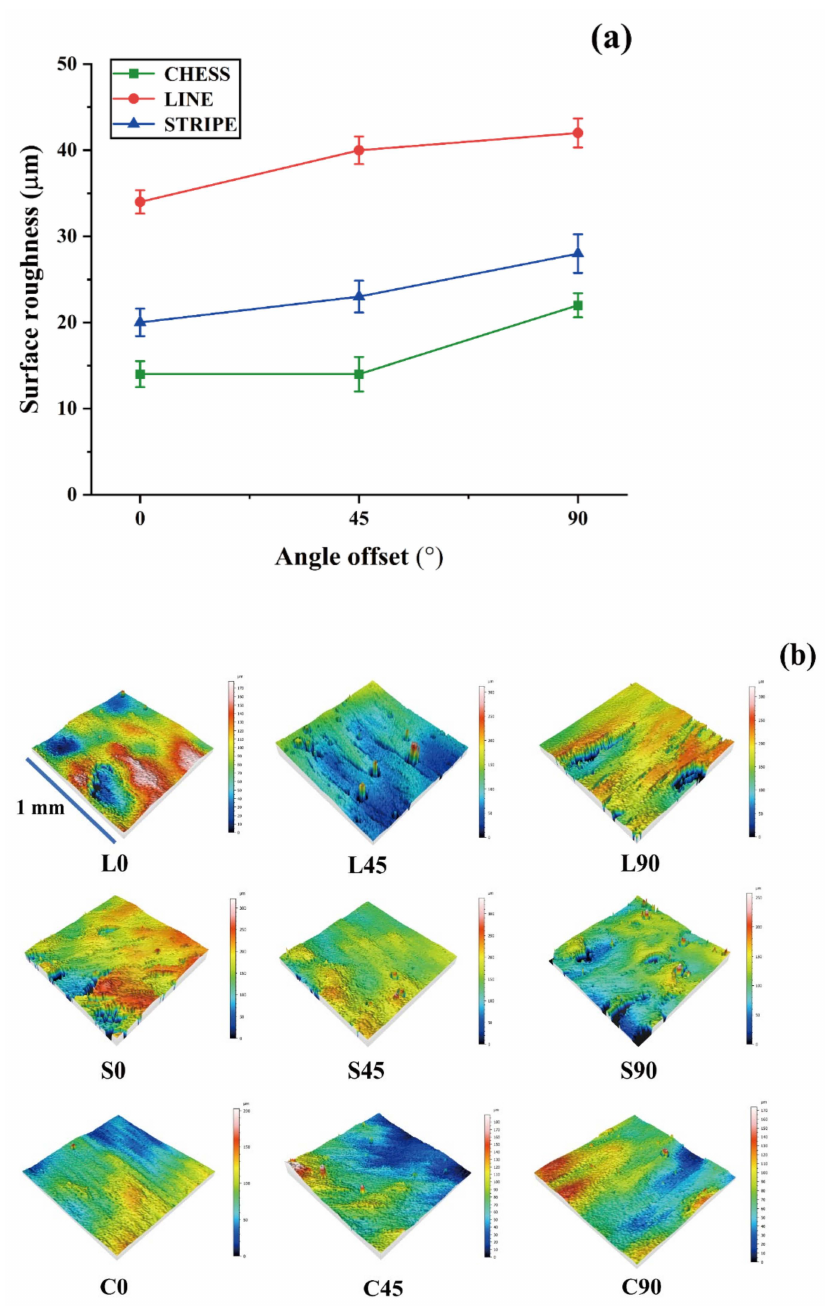
Figure 6. Surface roughness of L-PBF samples under different combinations of scanning strate- gies. ( a ) Surface roughness of L-PBF samples under different combinations of scanning strategies; ( b ) surface micro-morphologies of samples under different combinations of scanning